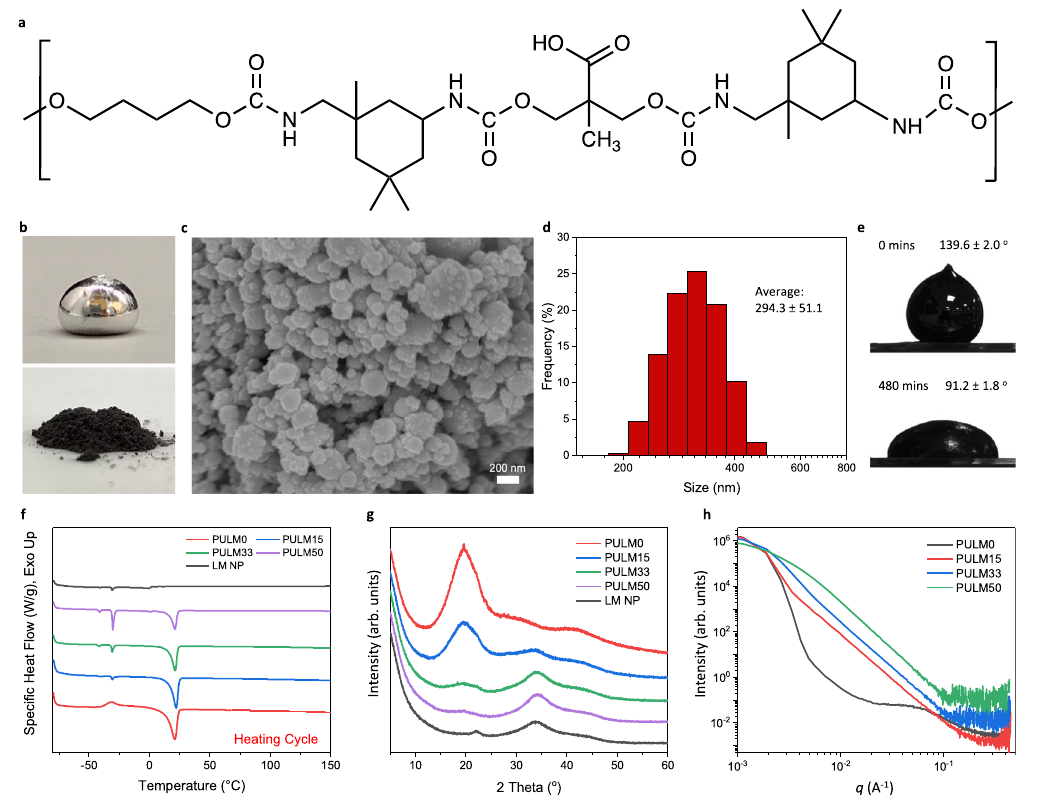
Fig. 1 | Material characterization of LMNPs and PULM nanocomposites. a Chemical structure of elastomer matrix PULM0. b Digital images of bulk liquid metalwithasilverre fl